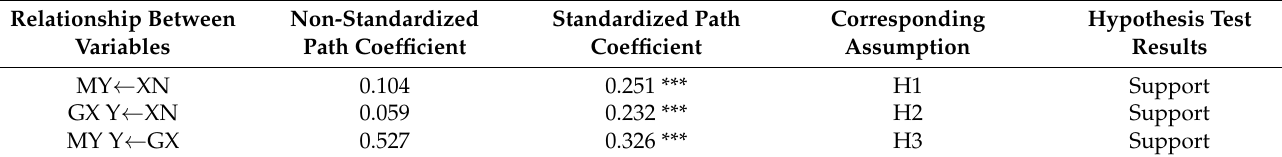
Table 14. Research assumptions and test